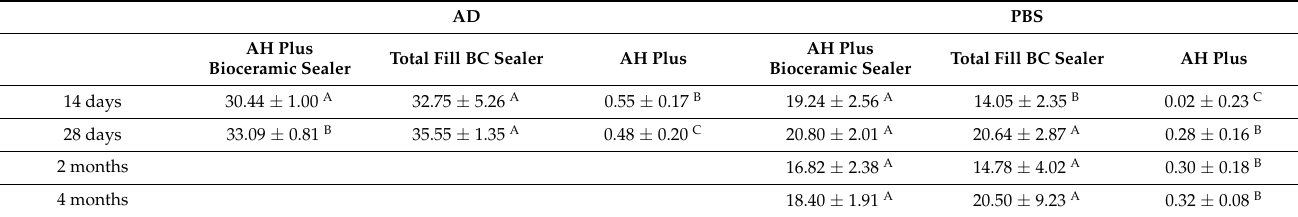
Table 1. Means and standard deviations: solubility of AH Plus Bioceramic Sealer, Total Fill BC Sealer, and AH Plus in AD over 28 days and in PBS over 4 months, respectively. Superscript letters indicate statistically significant differences at measurement dates in AD and PBS ( p <